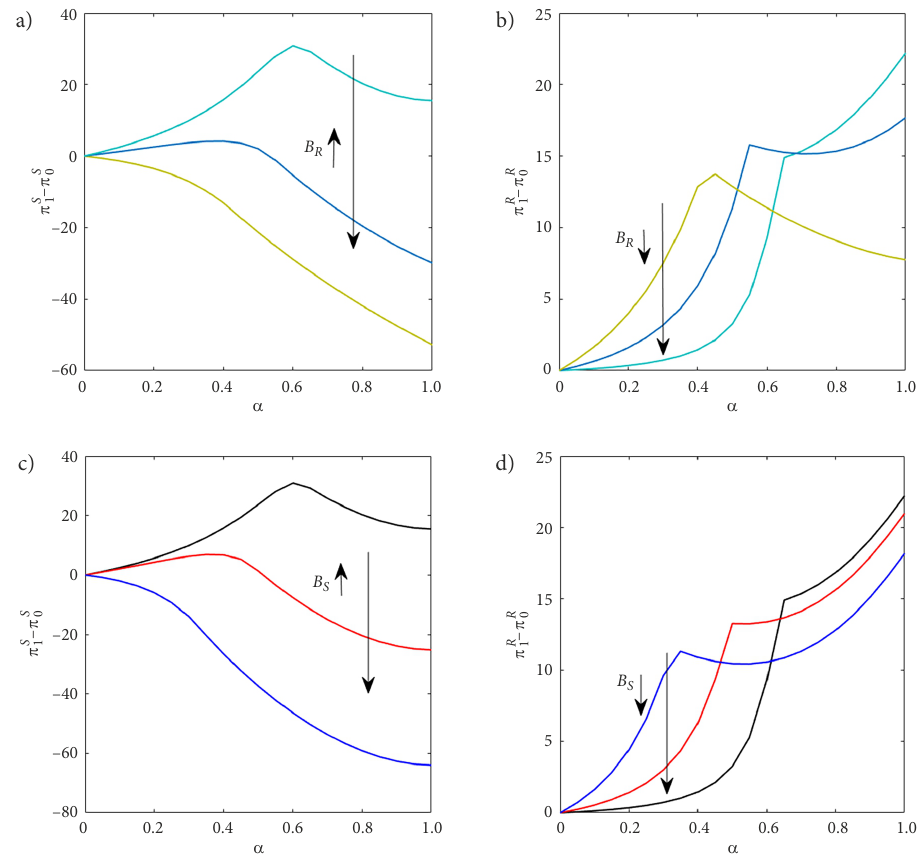
Figure 6. Impact of supply chain capital level for any division of